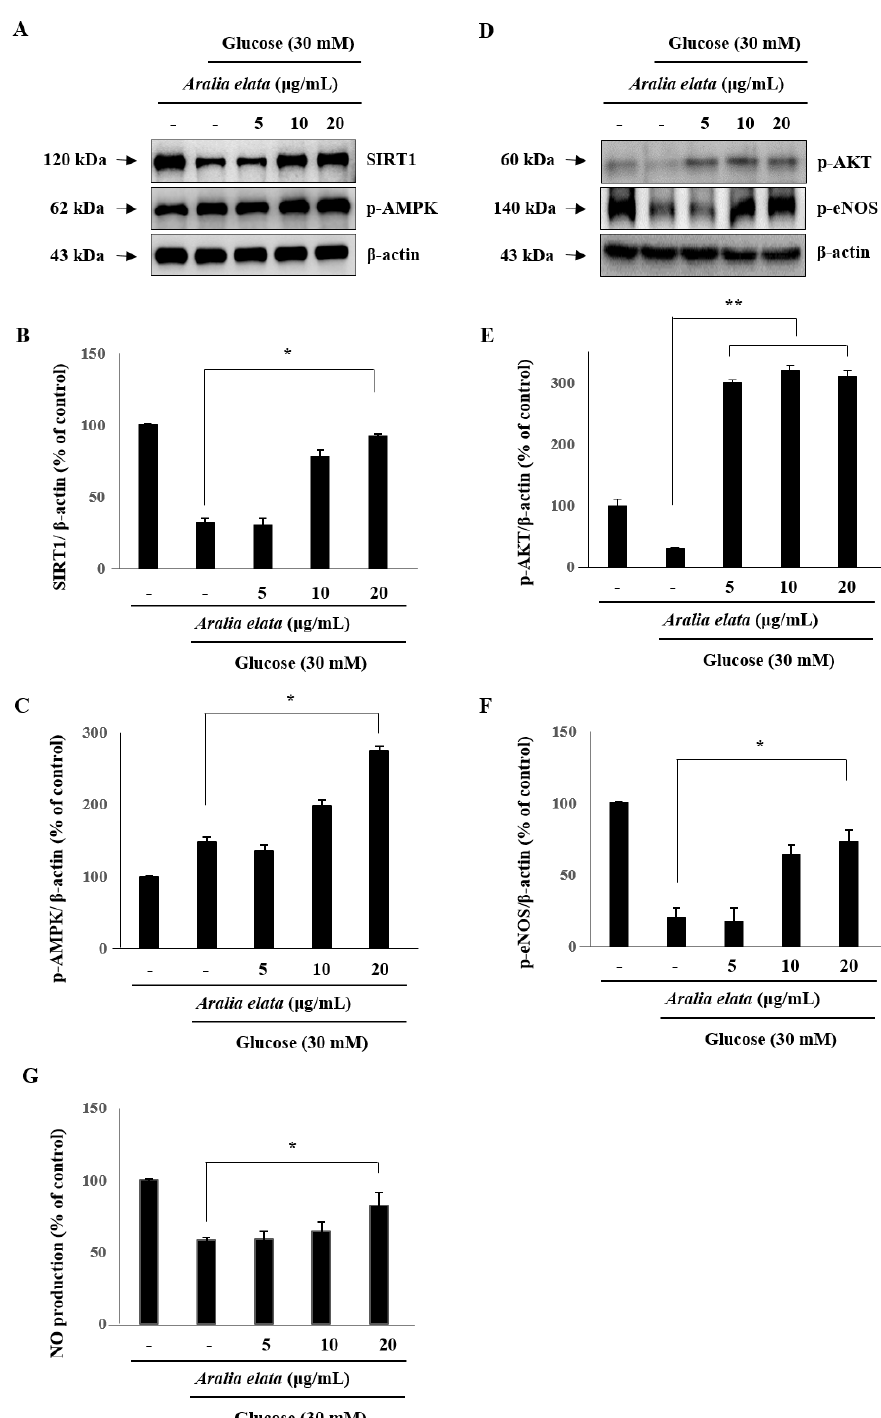
Figure 6. E ff ect of AS on SIRT / AMPK and AKT / eNOS signaling in HUVECs. Cells were cultured in media alone, media containing HG, or media containing HG and 20 µ g / mL AS for 24 h, and then subjected to Western blot analysis and NO production assays. ( A – C ) SIRT1 and p-AMPK levels and ( D – F ) p-AKT and p-eNOS levels relative to β -actin. ( G ) NO production in the di ff erent cell groups. * p < 0.05; ** p < 0.01 vs. the HG group.